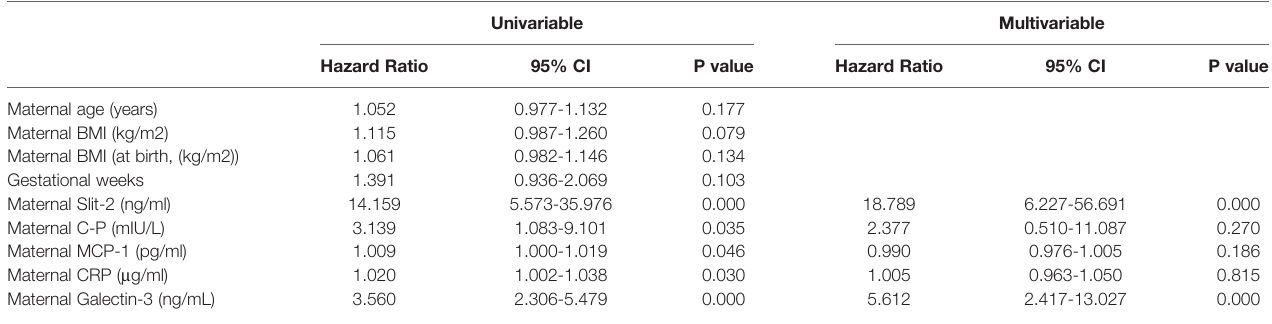
TABLE 3 | Logistic regression analysis for GDM.